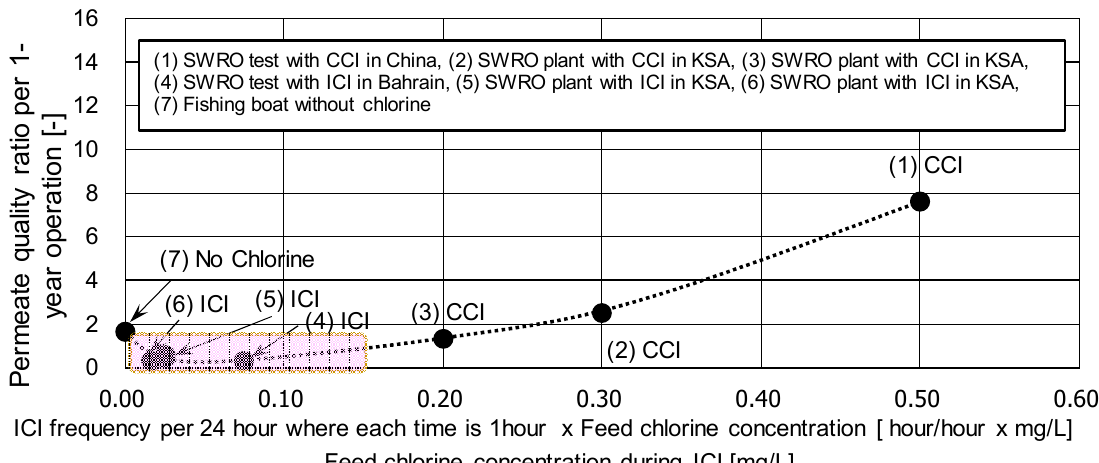
Figure 14. Permeate water quality per 1 year operation in SWRO desalination plants. Data from [90].